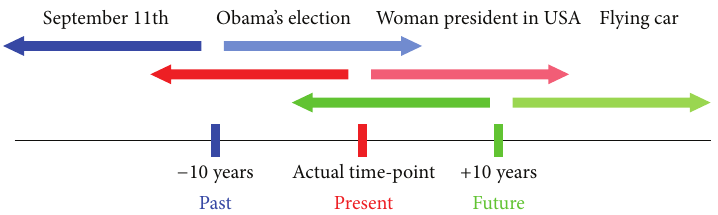
Figure 1: Stimuli and procedure. Participants were required to project themselves in three different self-locations in time (past, present, or future) and determine whether the event being presented was located in the past or the future relative to the current